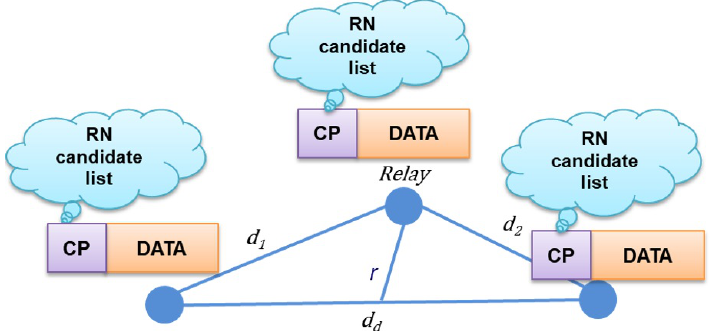
Figure 4. Transfer selected cooperator